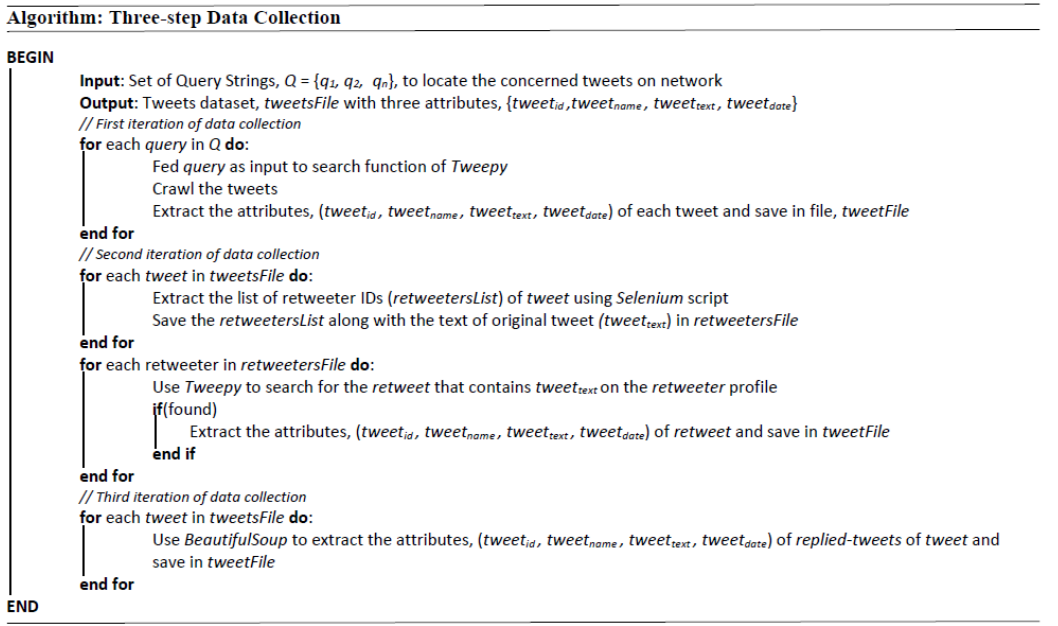
Figure 1. Pseudocode for three-step data collection.